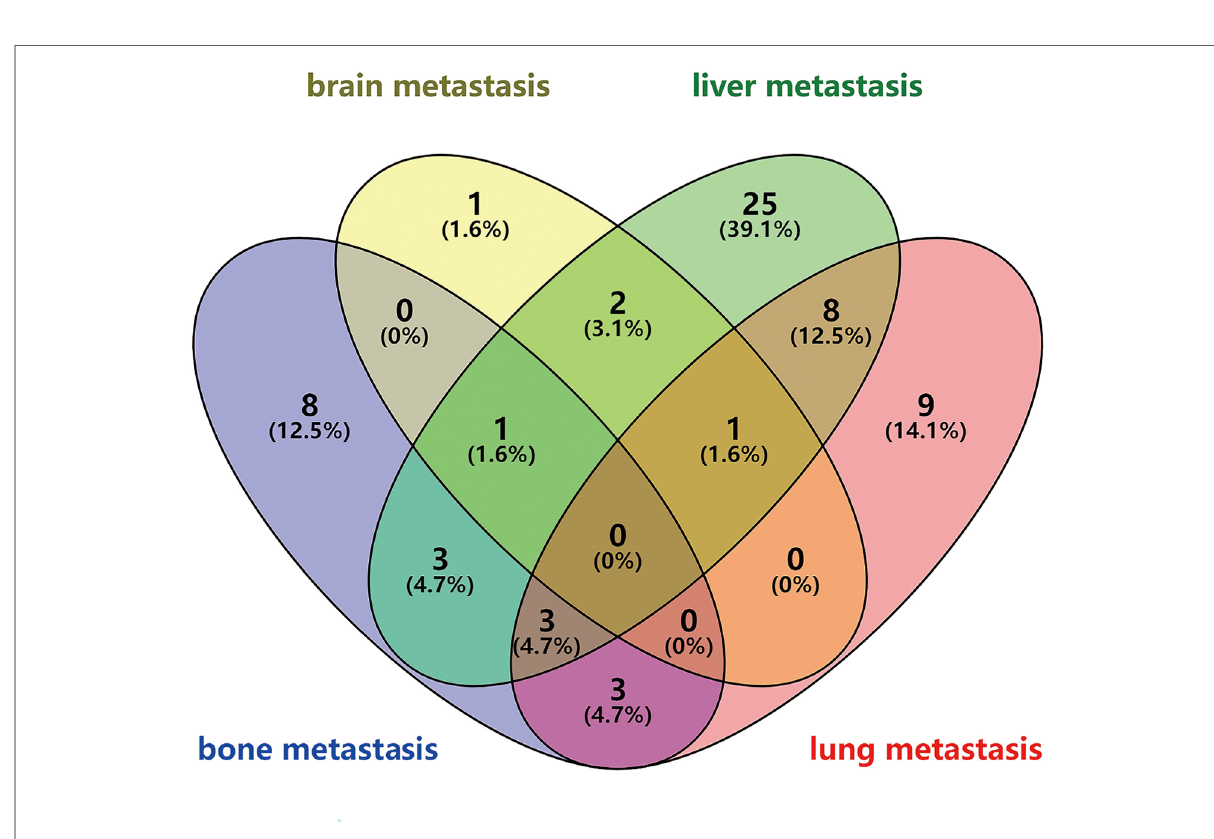
FIGURE 8 Venn diagram of different organ